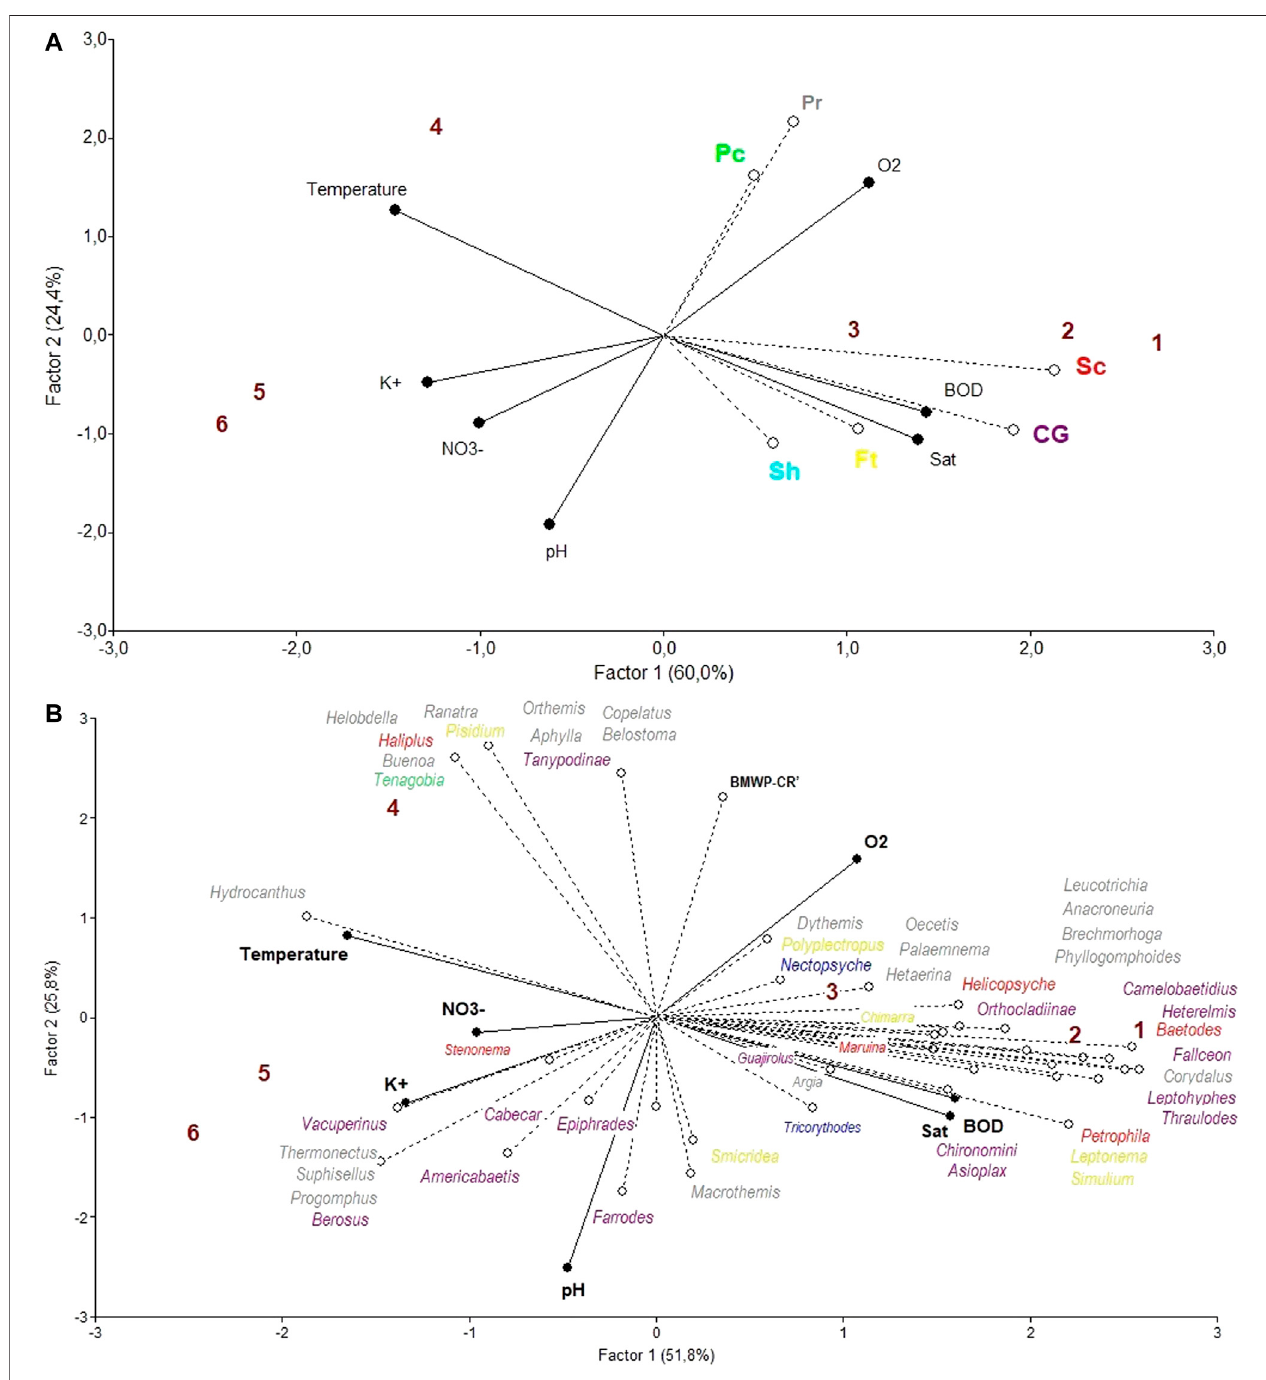
FIGURE 9 | Site ordination for the Colorado river (1 – 3) and the Las Palmas river (4 – 6) with a triplot PLS analysis using physical-chemical values as independent variables and (A) functional feeding group abundances as dependent variables. CG (cid:2) Collector-Gatherers, Ft (cid:2) Filterers, Pc (cid:2) Piercers, Pr (cid:2) Predators, Sc (cid:2) Scrapers, and Sh (cid:2) Shredders; (B) generic macroinvertebrate abundance and the BMWP ′ -CR index as dependent variables (FFG categories: purple (cid:2) collector-gatherers, yellow (cid:2) fi lterers, green (cid:2) piercers, grey (cid:2) predators, red (cid:2) scrapers, blue (cid:2) shredders).